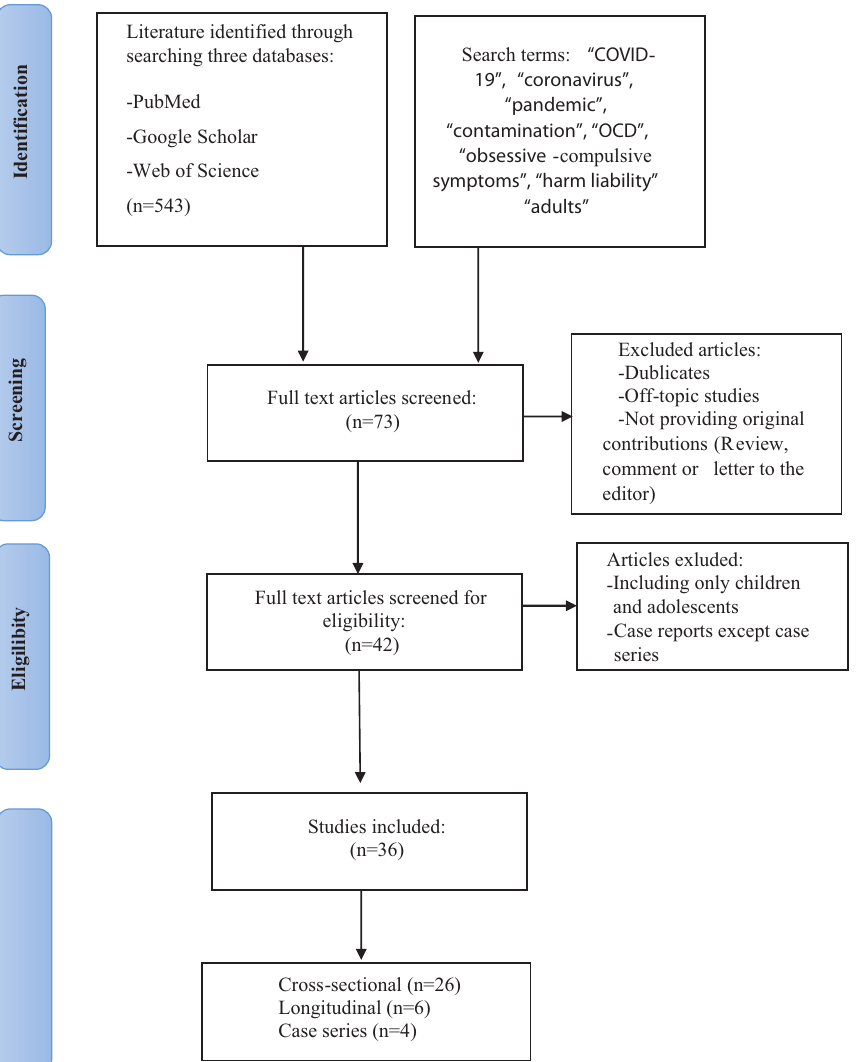
Figure 1. Flowchart on search